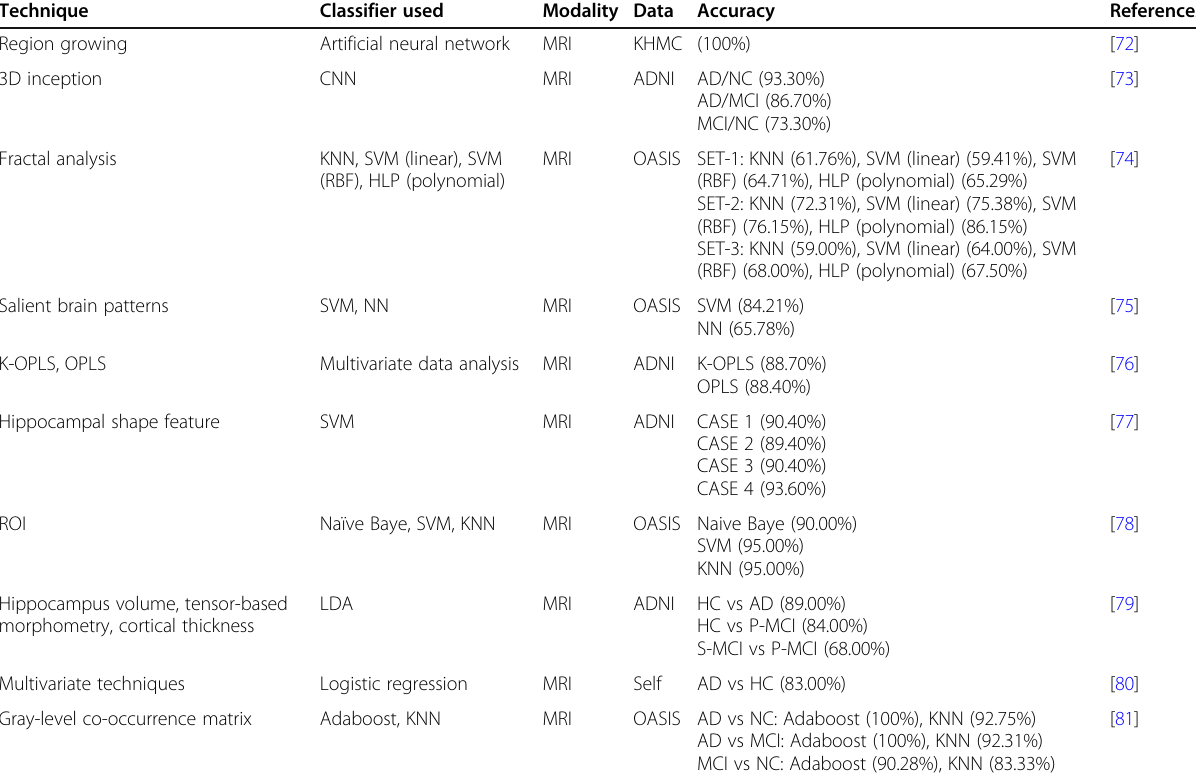
Table 1 Use of different ML classifiers for AD diagnosis using MRI scans